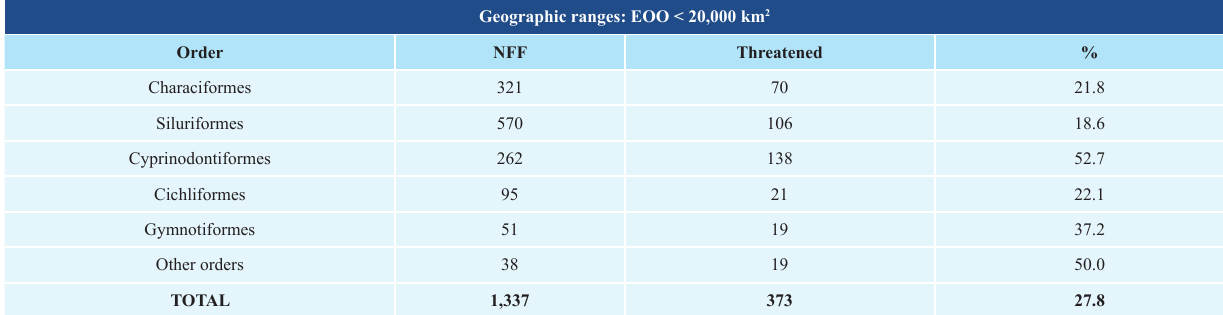
TABLE 3 | Summary of the IUCN–RL data for 1,337 NFF species with geographic range estimates less than 20,000 km 2 . EOO = Extent of